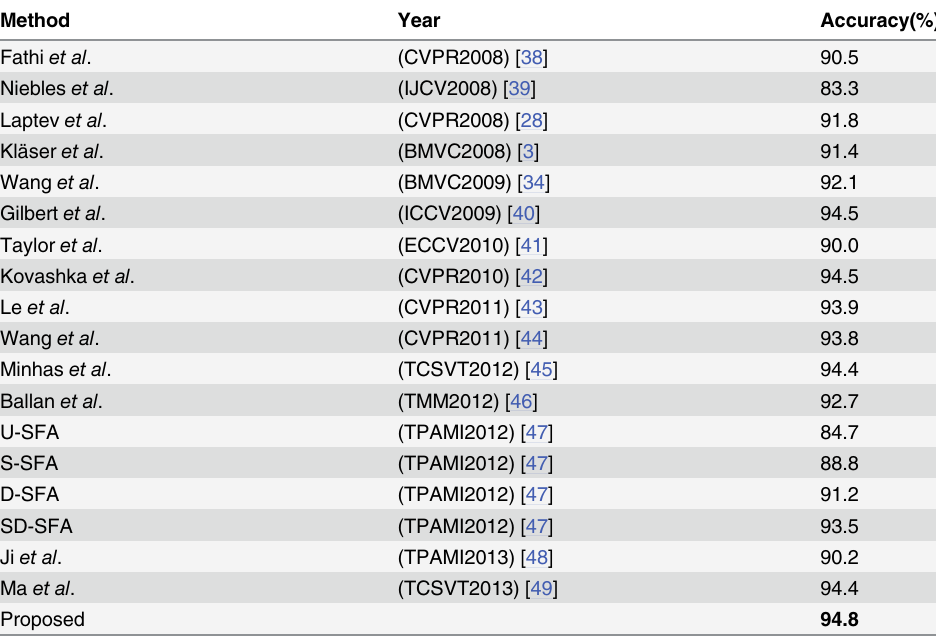
Table 2. Comparison with state of the arts on KTH.